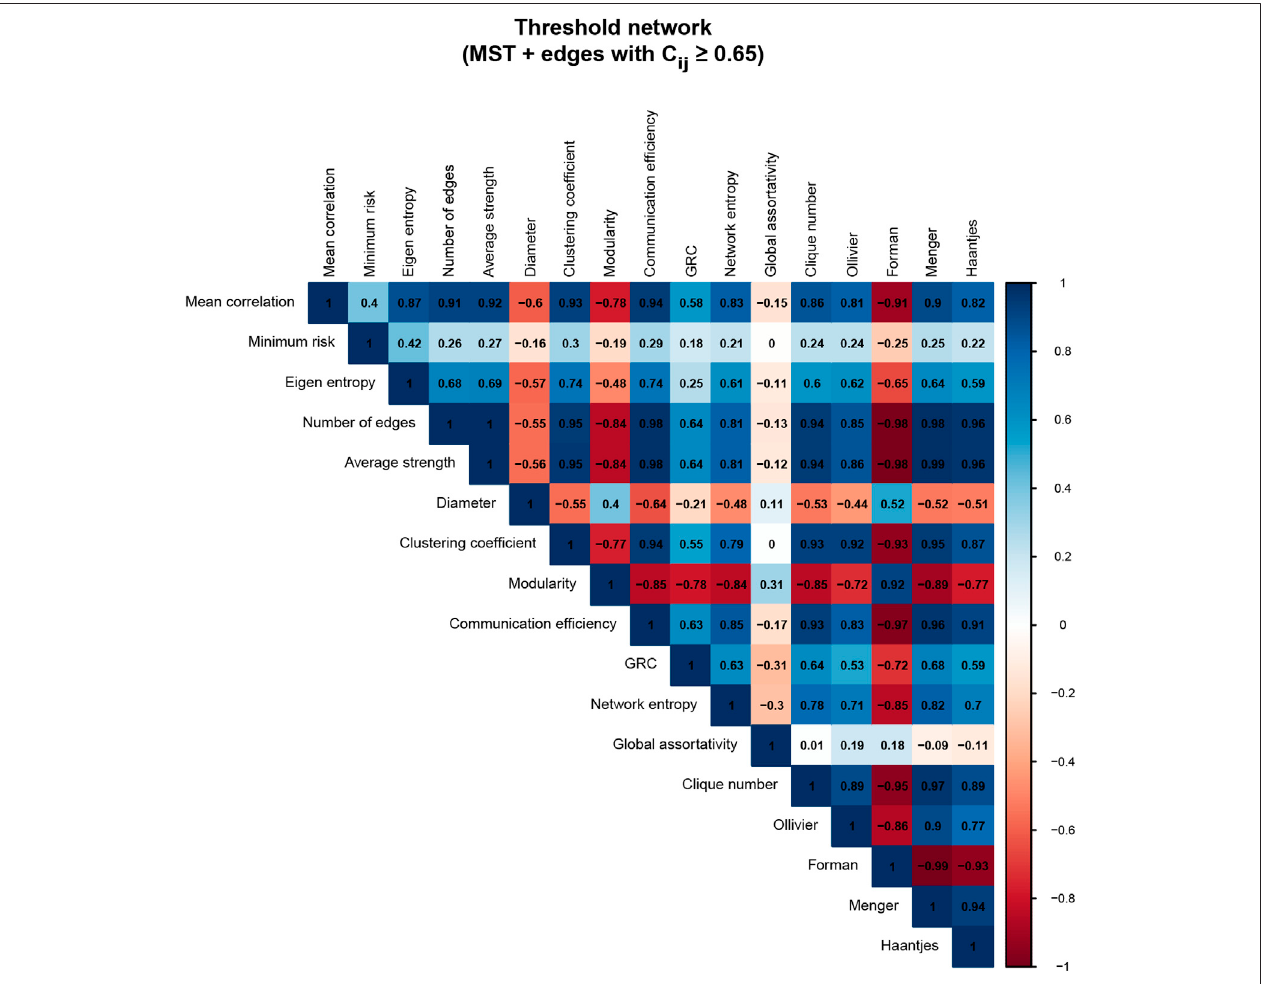
FIGURE 3 | Correlations between generic indicators and network characteristics of the global market indices networks S τ ( t ), constructed from the correlation matrices C τ ( t )ofwindowsize τ (cid:1) 80 daysandanoverlappingshiftof Δ τ (cid:1) 20 daysoveraperiodof14 years(2000 – 2014).Thethresholdnetworks S τ ( t )wereconstructed by adding edges with correlation C τ ij ( t ) ≥ 0 . 65 to the minimum spanning tree (MST).